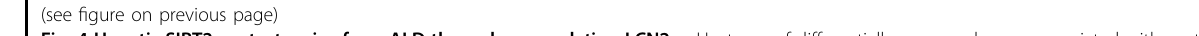
Fig. 4 Hepatic SIRT2 protects mice from ALD through upregulating LCN2. a Heatmap of differentially expressed genes associated with acute- phase response (Gene Ontology: 0006953) identi fi ed by RNA-seq using liver tissues from pair- or EtOH-fed LoxP or SIRT2 -KO mice ( n = 3). b , c qRT- PCR ( b ) and Western blot ( c ) analyses of LCN2 mRNA and protein expression in murine livers. d , e qRT-PCR ( d ) and Western blot analysis ( e ) of LCN2 expression in SIRT2 knockdown ( SIRT2 KD) or control AML12 hepatocytes. f , g qRT-PCR ( f ) and Western blot analysis ( g ) of LCN2 in SIRT2 overexpression hepatocytes. h – o LoxP and SIRT2 -KO male mice tail-vein injected with AAV8-Ctrl (Ctrl) or AAV8-LCN2 (LCN2) were treated with pair (Pair) or ethanol diet (EtOH) according to NIAAA model construction ( n = 3 – 5/group). h Images of the indicated livers (scale bar, 1 cm), H&E staining of murine livers (scale bar, 50 μ m), IHC detection of 4-HNE and TUNEL (scale bar, 100 μ m). i , j Liver TG and MDA content of indicated mice. k Hepatic PTGS2 mRNA by qRT-PCR analysis of indicated mice. l , m Serum ALT and AST of indicated mice. n Quantitative analysis of TUNEL-positive hepatocytes (magni fi cation, ×200). o Western blot analysis of cl.Caspase-3 protein in murine liver tissues. Student ’ s t- test was used for statistical evaluation. Data are shown as means ± SD and are considered statistically signi fi cant at * P < 0.05, ** P < 0.01, and *** P <